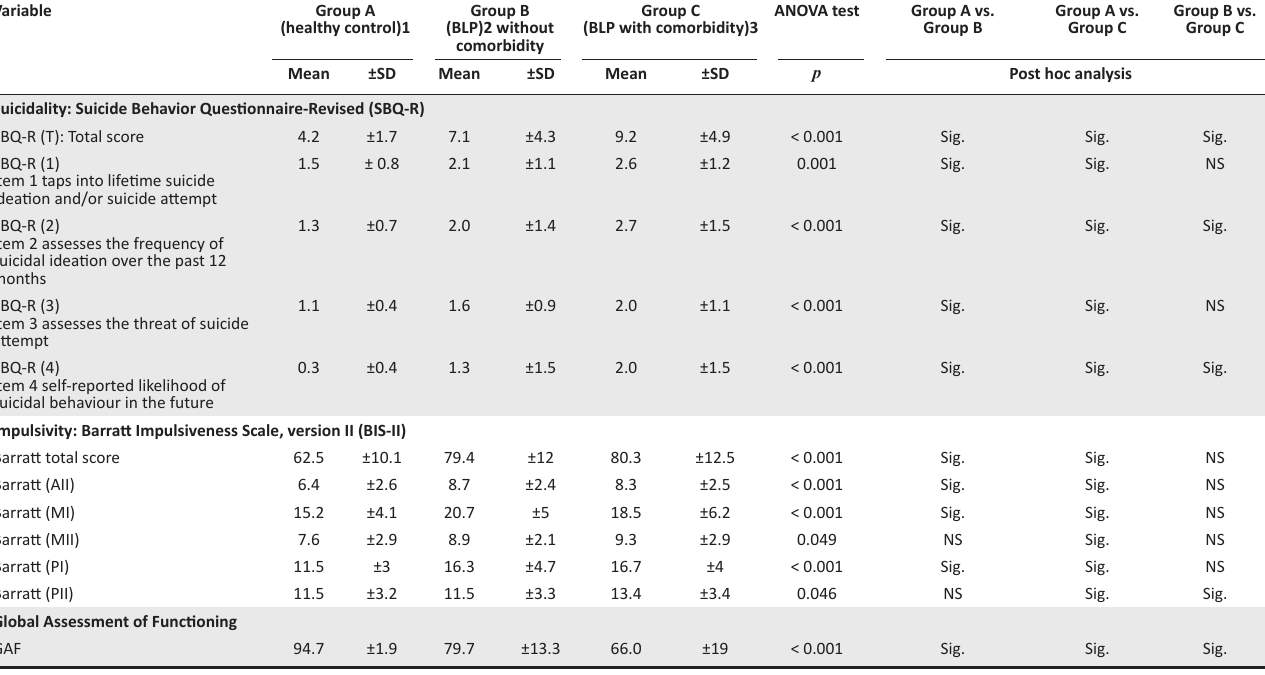
TABLE 2: Suicidality and impulsivity among the three studied groups.